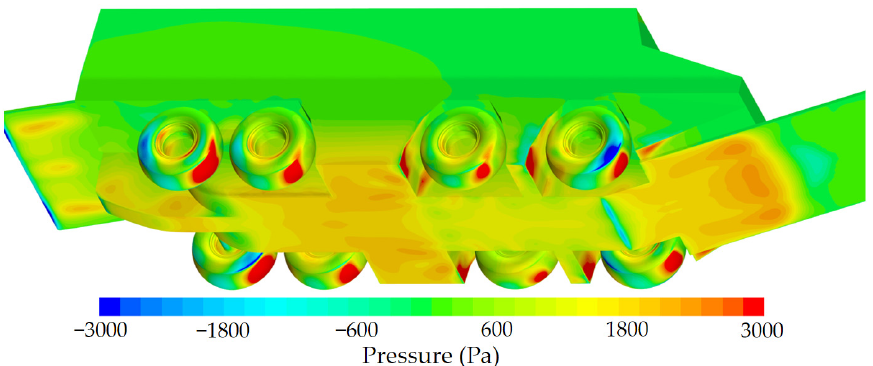
Figure 14. Pressure distribution of TS model at Fr = 0.624, where red represents high pressure.